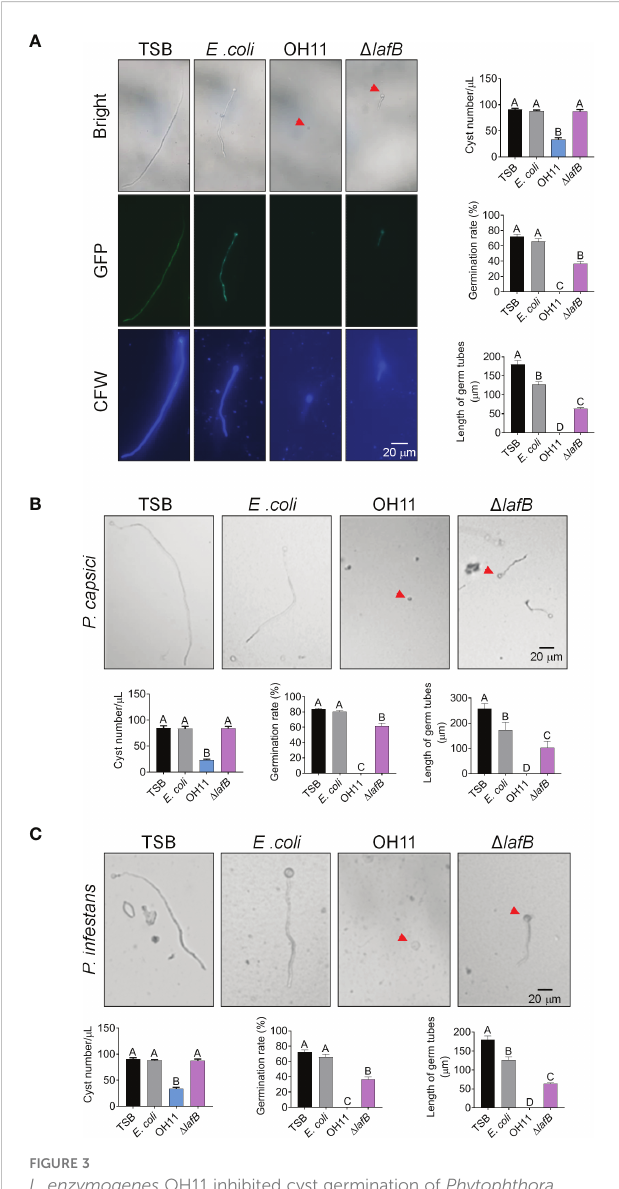
FIGURE 3 L. enzymogenes OH11 inhibited cyst germination of Phytophthora . (A) Wild-type OH11 degraded P. sojae cysts, whereas the HSAF- de fi cient mutant D lafB did not, but inhibited cyst germination. GFP-labeled P. sojae cysts were mixed with TSB, E coli , OH11, or D lafB , and cultured at 25°C for 6 hours. Compared to TSB control, OH11 treatment completely inhibited cyst germination in P. sojae and the number of cysts after OH11 treatment was signi fi cantly reduced. At the same time, both the germination rate and the germinated tube length of P. sojae were signi fi cantly reduced after D lafB treatment. Three replicates of each sample were analyzed using a one-way ANOVA test. Red arrows indicate P. sojae cysts. WT-treated cysts showed a lower GFP signal, indicating that WT-treatment resulted in cell death of P. sojae cysts. Cysts were stained with chitin-binding CFW to make them clearer to observe. (B, C) WT degraded P. capsici (B) and P. infestans (C) cysts, whereas D lafB only inhibited germination of the corresponding cysts. P. capsici and P. infestans cysts were mixed with TSB, E coli , OH11, and D lafB , respectively, and cultured at 25°C ( P. capsici ) or 18°C ( P. infestans ) for 6 hours ( P. capsici ) or 12 hours ( P. infestans ). Three replicates of each sample were analyzed with a one-way ANOVA test. Red arrows indicate P. capsici or P. infestans